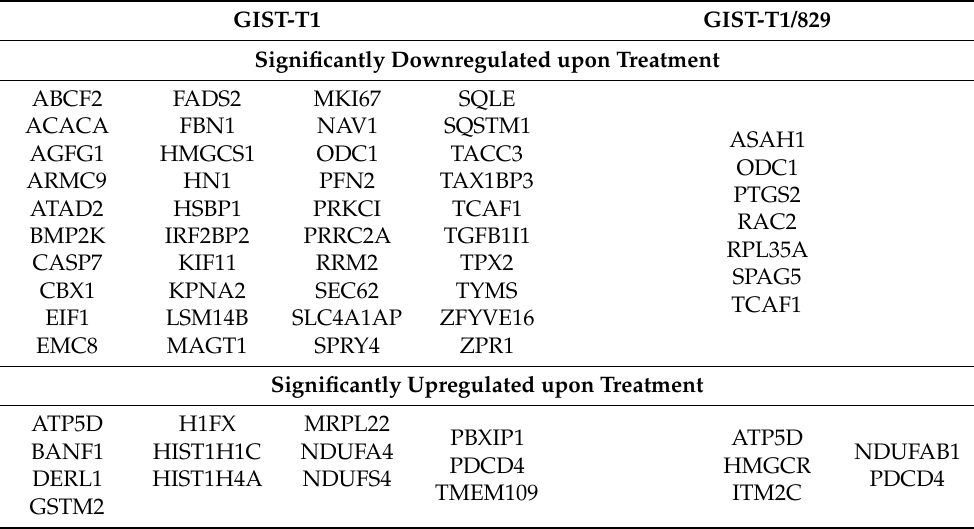
Table 1. Differentially expressed proteins upon treatment of GIST cells with IM/MK-4440 combina- tion for 20 h. GIST-T1 GIST-T1/829 Significantly Downregulated upon